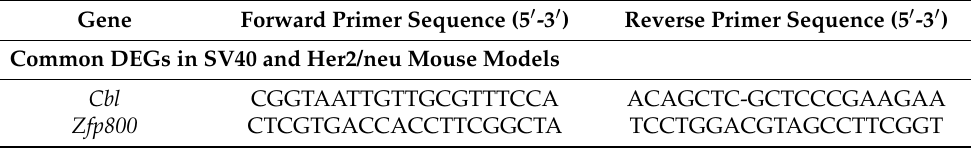
Table 1. The primer sequence for each specific genes of interest. Gene Forward Primer Sequence (5 (cid:48) -3 (cid:48) ) Reverse Primer Sequence (5 (cid:48) -3 (cid:48) ) Common DEGs in SV40 and Her2/neu Mouse Models Cbl CGGTAATTGTTGCGTTTCCA ACAGCTC-GCTCCCGAAGAA Zfp800 CTCGTGACCACCTTCGGCTA